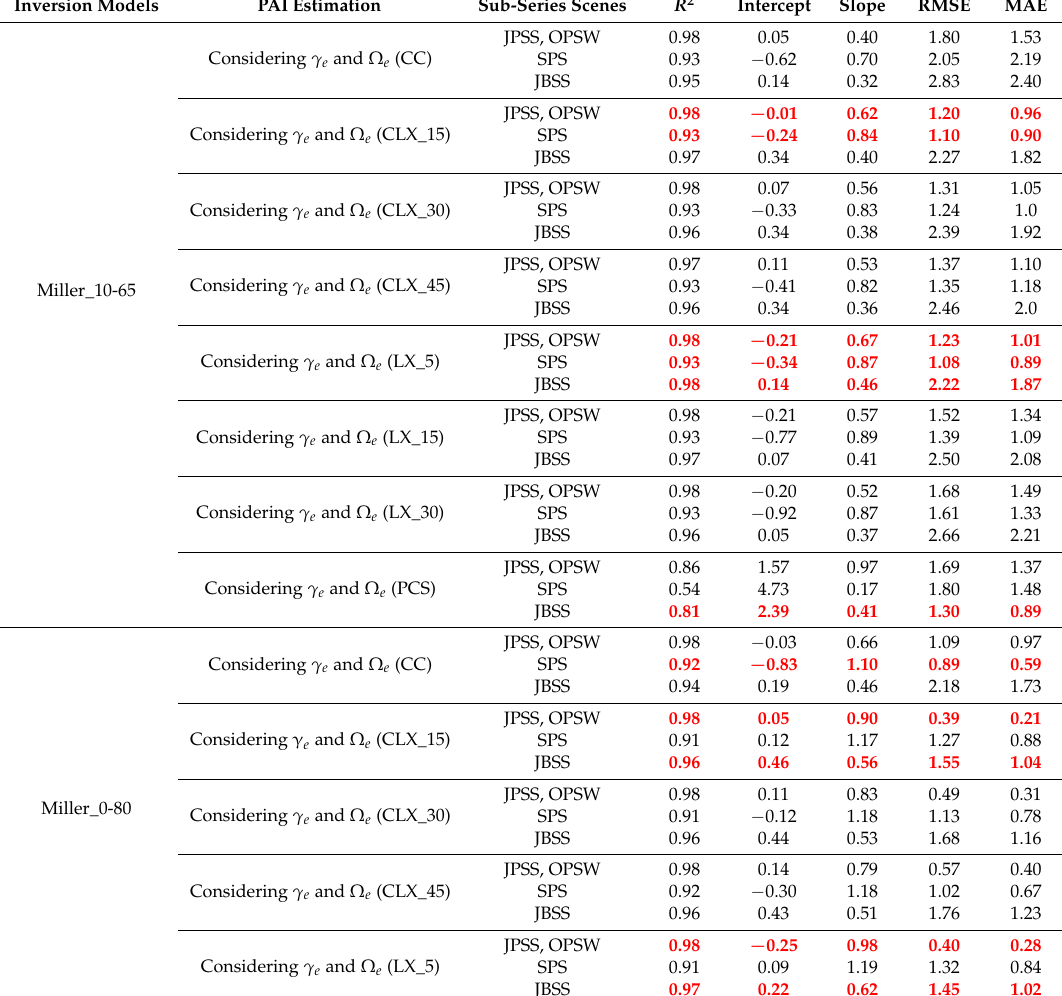
Table A1. Correlation statistics between true and estimated PAI calculated from seven inversion models with consideration of G e , γ e , and Ω e at three groups of sub-series scenes. RMSE and MAE are expressed in PAI units (m 2 /m 2